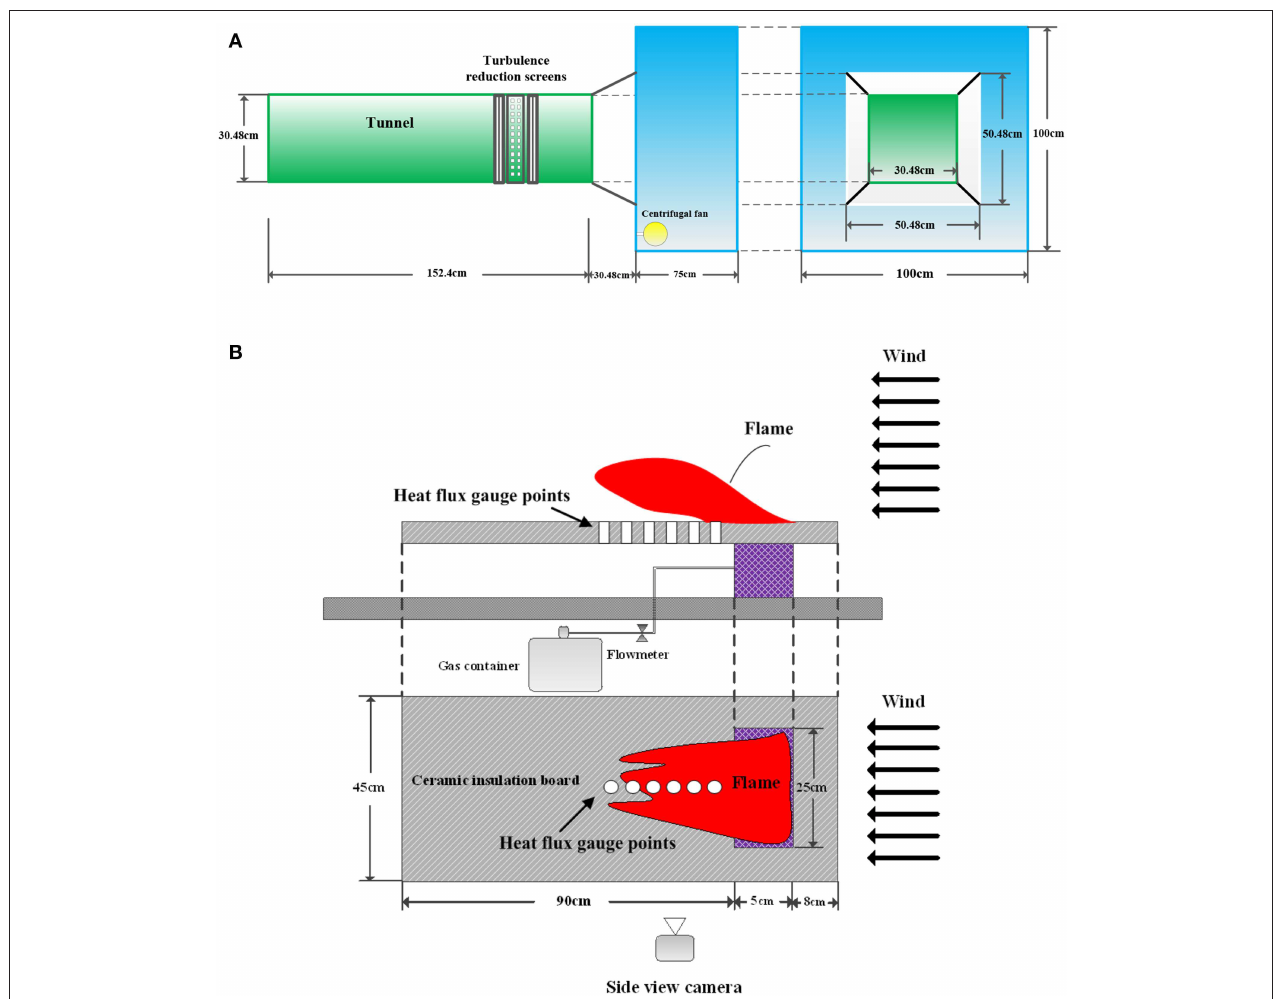
FIGURE 2 | Experimental setup. (A) Wind tunnel apparatus. (B) Test section